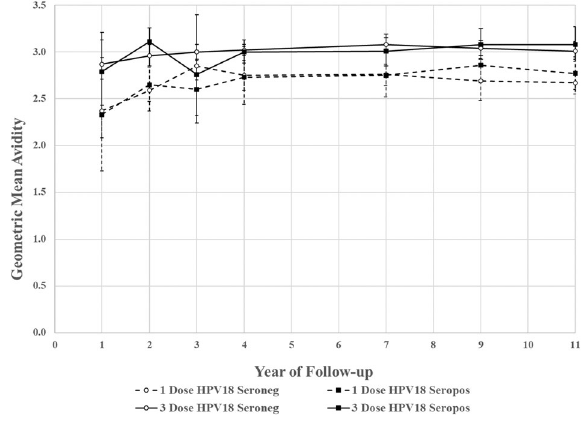
3 HPV16 antibody avidity over time among HPV16 seronegative at initial HPV vaccination, strati fi ed by number of HPV vaccine doses received and HPV18 serostatus at time of initial HPV vaccination. The solid lines indicate the three- dose group, strati fi ed by HPV18 seronegative (empty circles) and HPV18 seropositive (squares) at fi rst HPV vaccination. The dashed lines indicate the one-dose group, strati fi ed by HPV18 seronegative (empty circles) and HPV18 seropositive (squares) at fi rst HPV vaccination. Error bars represent 95% con fi dence intervals (CI). Regression lines are estimated by regressing log(avidity) on either an intercept, an indicator for the second study visit, and/or study year, and reporting on the parameter 100(e β -1).